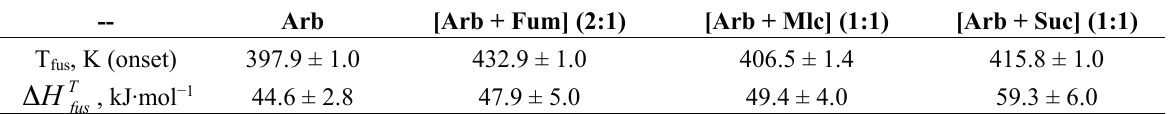
Figure 6. DSC curves for arbidol base and its salts recorded at 10 °C·min –1 heating rate. Table 3. Thermophysical data for arbidol and its